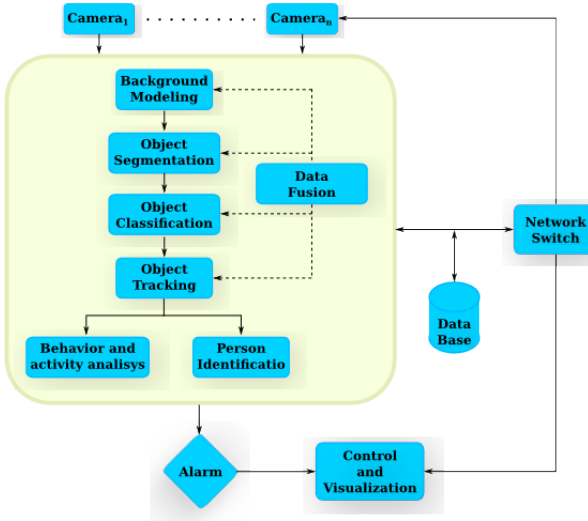
Figure 1. General video surveillance schema (Ko, 2008).